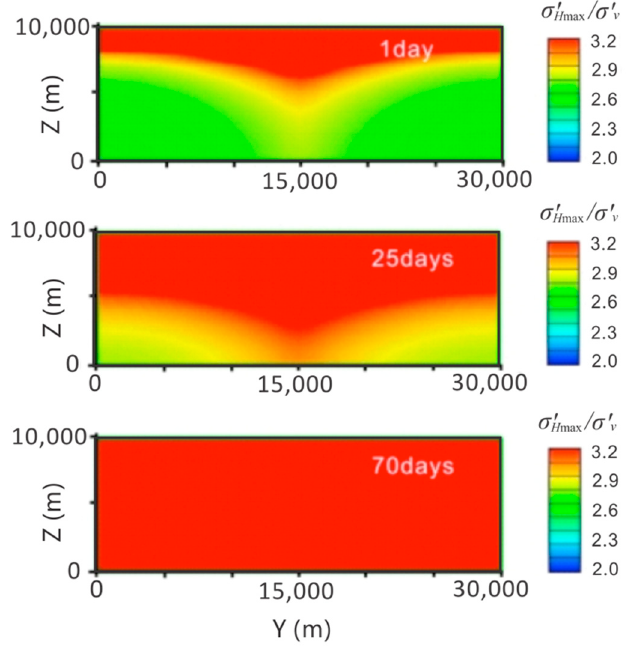
Figure 7. The distribution of the stress ratio σ (cid:48) H max / σ (cid:48) v during the fluid intrusion.